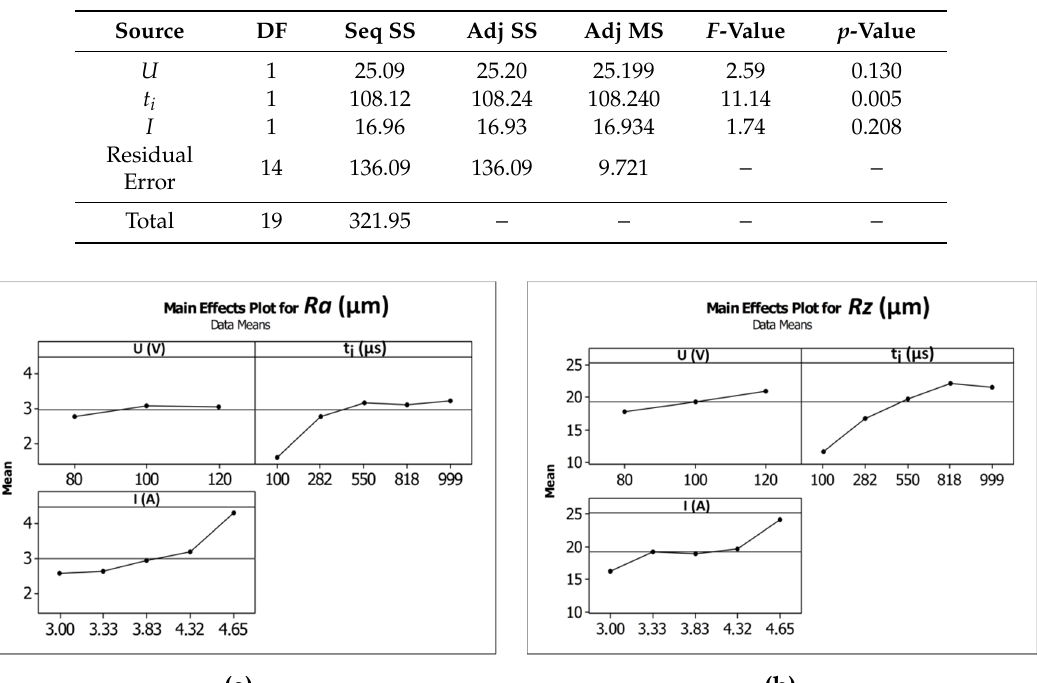
(d) Figure 13. Images of the internal surface of the hole for the machining parameters. ( a ) U = 80 V, t i = 818 μs, I = 3.33 A, and AR = 6; ( b ) U = 100 V, t i = 100 μs, I = 3.83 A, and AR = 10; ( c ) U = 100 V, t i = 282 μs, I = 4.32 A, and AR = 23; ( d ) U = 100 V, t i = 550 μs, I = 3.83 A, and AR = 12. The darker machined surface at the bottom of the hole was subjected to a qualitative analysis using a scanning electron microscope (SEM) with an energy dispersive spectroscopy system (EDS) produced by JEOL Ltd. (Tokyo, Japan) , as shown in Figure 14. An analysis of the results revealed a